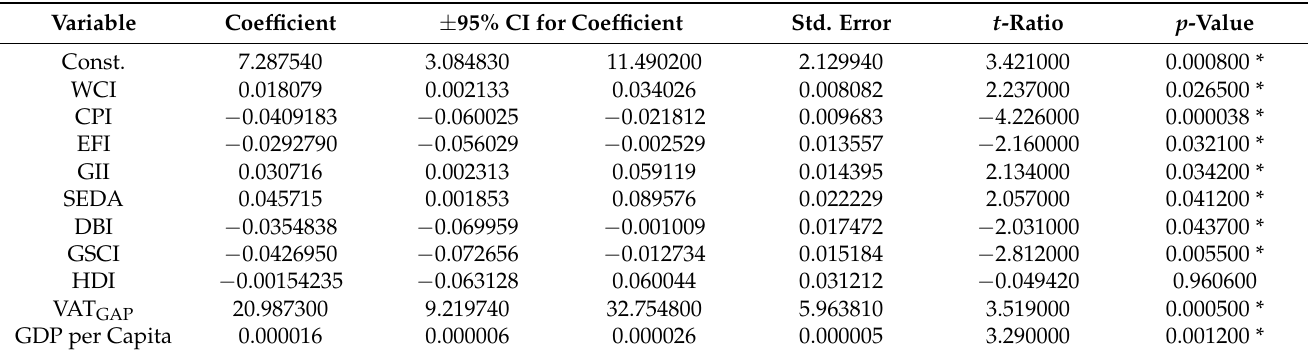
Table 1. The regression coefficients estimation of the pooled regression model for Basel AML index within EU destination